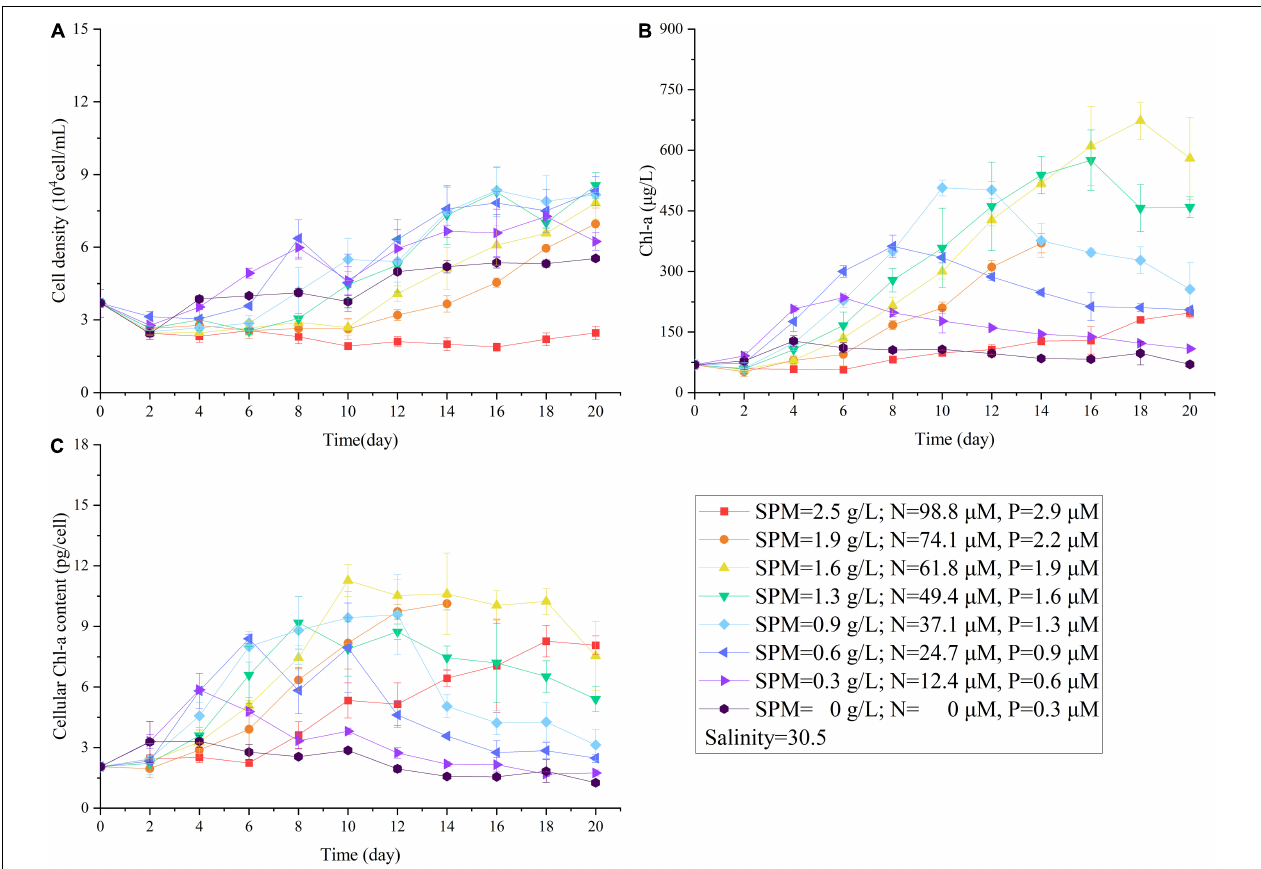
FIGURE 5 | The changes in cell density (A) , Chl- a concentration (B) , cellular Chl- a content (C) of A. carterae under different concentrations of nutrient and SPM in the two-factor (SPM and nutrient) experiment.